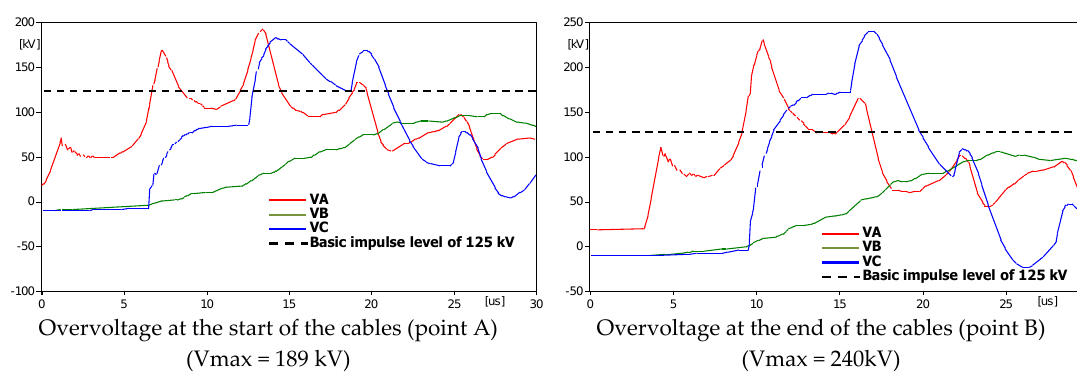
Figure 32. A 500 m underground cable.